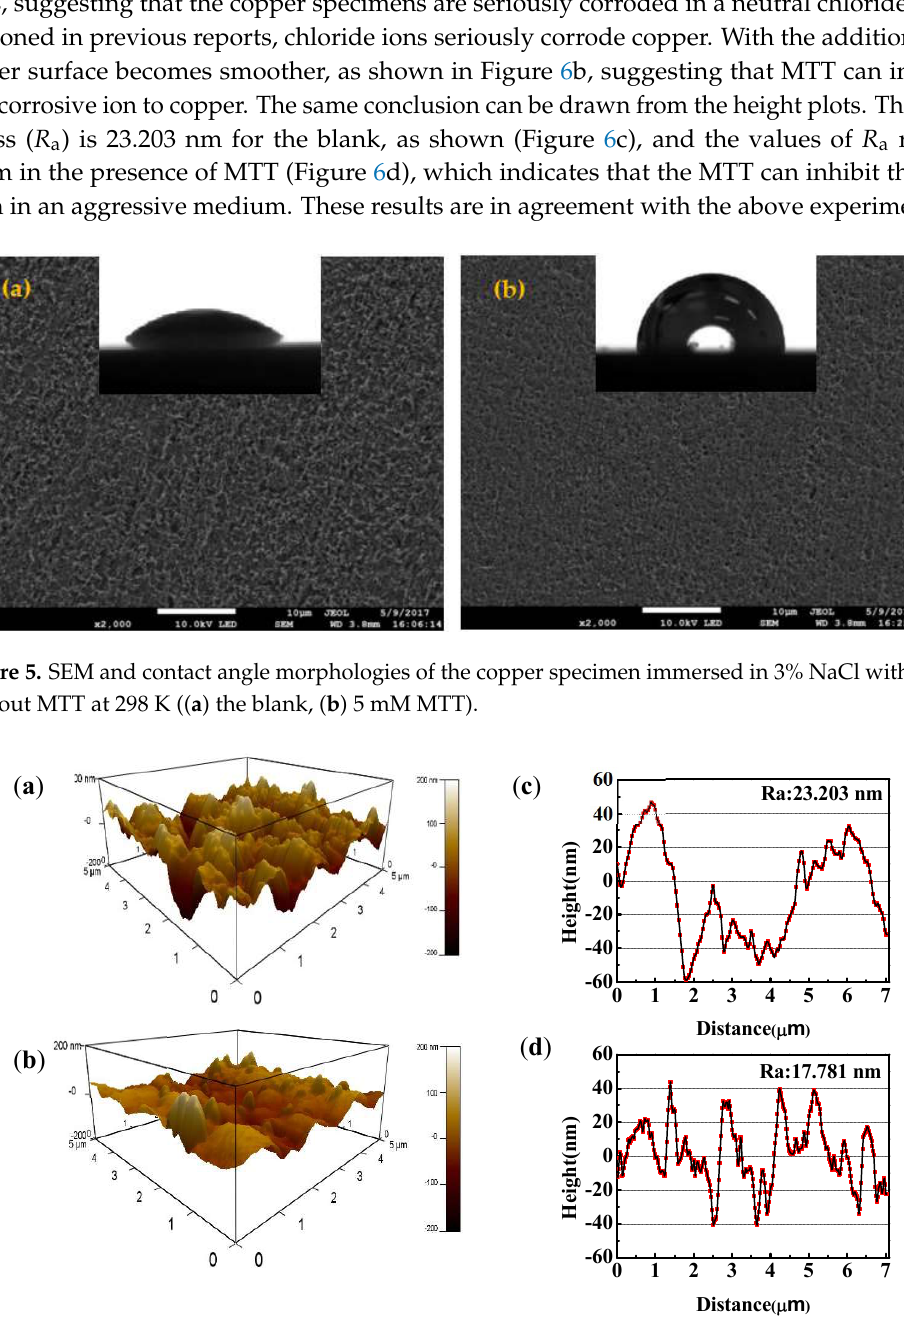
Figure 6. AFM morphologies of the copper specimen immersed in the blank solution with and without 5 mM MTT (( a , c ) the blank, ( b , d ) 5 mM MTT).